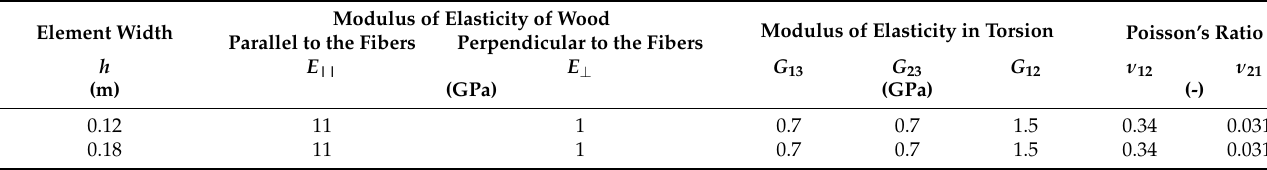
Table 3. Input parameters of wood elements.